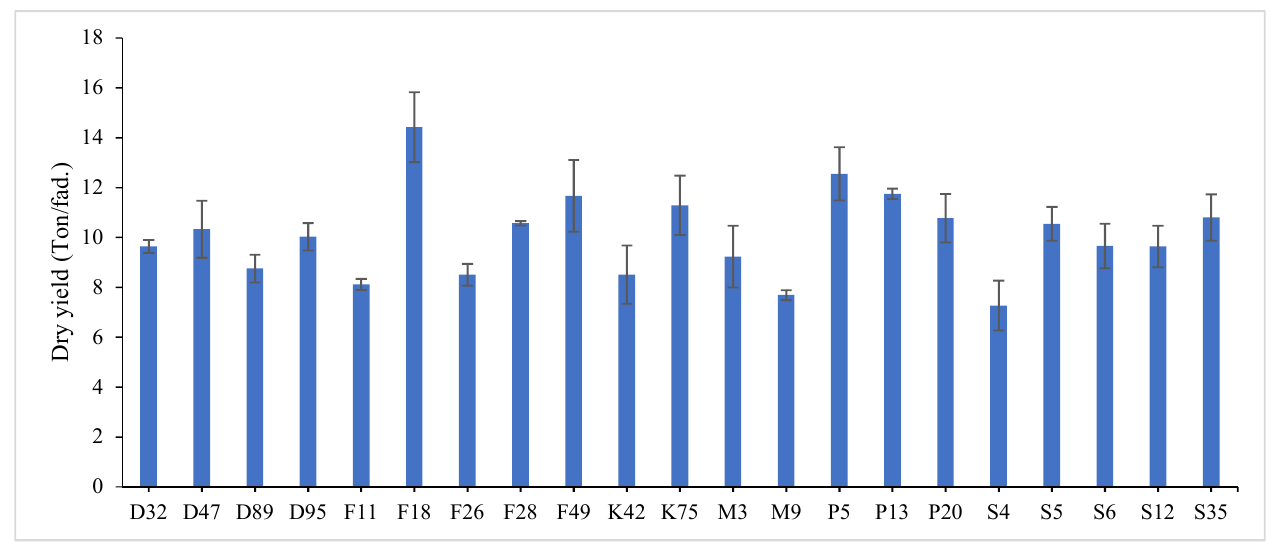
Figure 4. Mean performance of total fresh yield (ton/fed) of twenty-one alfalfa genotypes at combined across the two years. Bar represents the standard deviation.